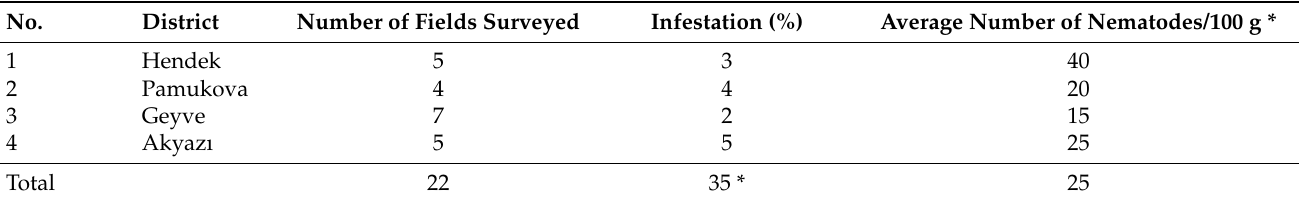
Table 4. Infestation rate of the sampled fields by Pratylenchus spp. in Hendek, Pamukova, Geyve, and Akyazı districts in wheat fields.